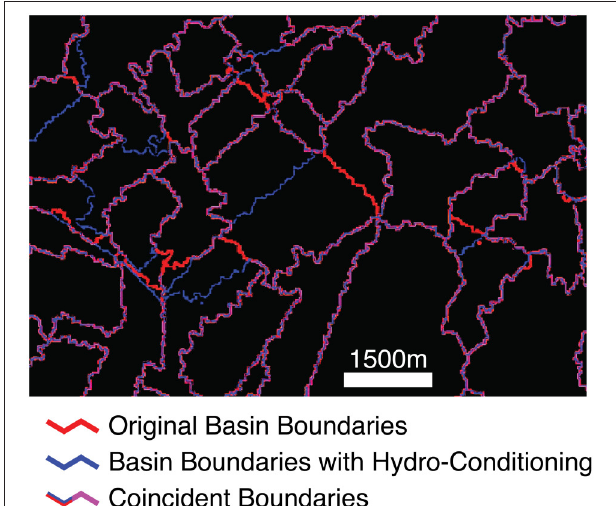
FIGURE 6 | Comparison of watershed sub-basin boundary delineations without ditches (red), with ditches (blue), and overlaid agreement